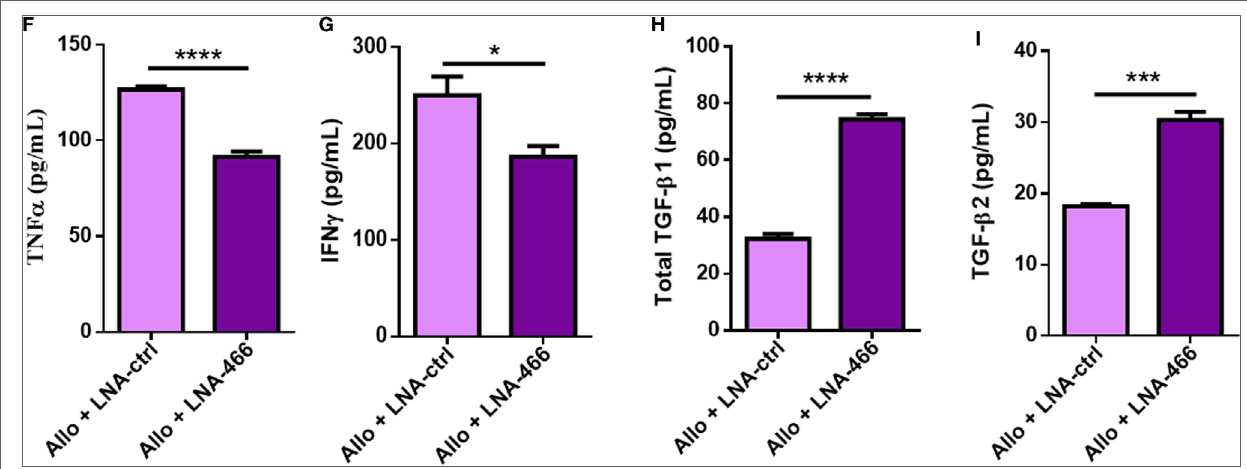
FigUre 6 | Locked nucleic acid (LNA) reduces intragraft effector cells and cytokines. Female C57BL/6 mice were given either syn (BL6) or allo (C 3 H) tail skin grafts. Mice receiving allografts were given either LNA-466 (10 mg/kg) or LNA-Ctrl (10 mg/kg) intraperitoneally 1 day before skin transplantation and every third day after that until termination of the study. Upon rejection, grafts were aseptically excised, minced, and enzymatically digested to dislodge graft-infiltrating cells (GICs). GICs were spun down, culture supernatants were collected, and live cells were used for flow cytometric analysis. Representative dot plots displaying naïve (CD62L Low , CD44 Neg ), memory (CD62L + , CD44 HI ), and effector (CD62L Low , CD44 HI ) cell types gated on CD8 + [ (a) , upper row] and CD4 + [ (a) , lower row] cells. Percentages for CD8 + and CD4 + are quantified in (B,c) , respectively. Dot plots of GICs double-positive for FoxP3 and CD62L, data are gated on CD4 + cells (D) , and quantified in (e) ; n = 7 (allogeneic + Ctrl) or 8 (allogeneic + LNA). GIC supernatants were collected and subjected to enzyme-linked immunosorbent assay for the interrogation of effector cytokines TNF α (F) and IFN γ (g) , as well as anti-inflammatory cytokines transforming growth factor (TGF)- β 1 (h) and TGF- β 2 (i) . Data are presented